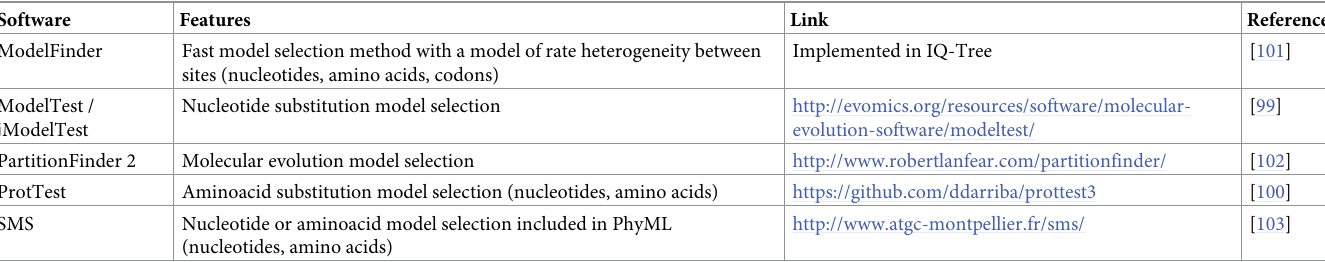
Table 6. List of programs for molecular evolution model